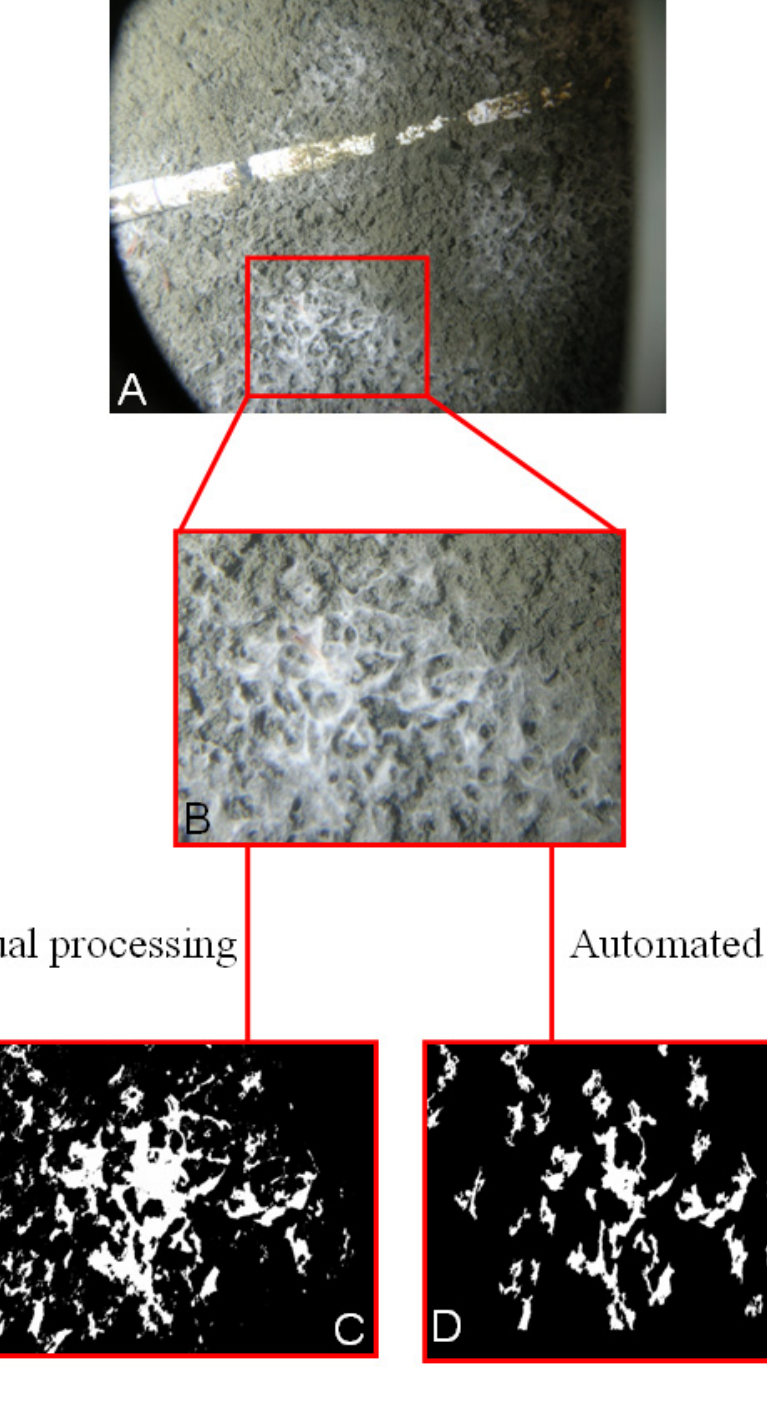
Figure 8. Example of a manual and automated processing of bacterial mats ( Beggiatoa spp.): ( A ) Original image as an example; ( B ) Zoomed area; ( C ) Result of the manual processing; and finally, ( D ) Result of the automated